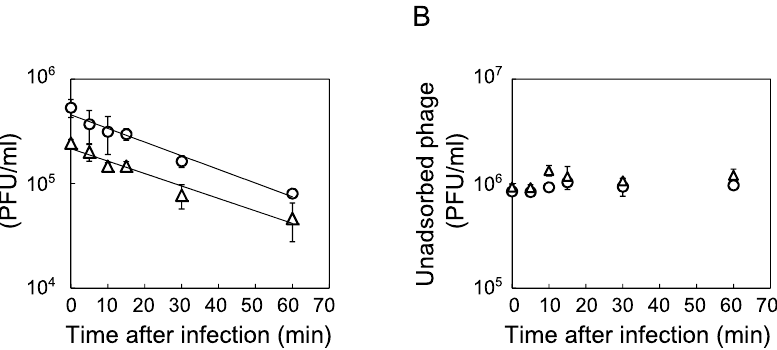
Figure 4. Time course of changes in density of free phage, infected E.coli , and total E.coli . The time course of changes in free phage density (PFU/ml) ( e ), infected cell density (PFU/ml) ( # ) and total cell density (CFU/ml) ( D ) for (A) Anc(C) infected with Anc(P), (B) M54(C) infected with Anc(P), (C) M54(C) infected with M54(P), (D) M163(C) infected with Anc(P), (E) M163(C) infected with M54(P), (F) M163(C) infected with M163(P), and (G) M163(C) infected with S94_3(P). Experiments were performed in duplicate. The rates of infected cell fitting straight lines to semi-logarithmic plots of infected cell density for (A) to (G) were 2.62 h 2 1 (r 2 =0.98), 1.21 h 2 1 (r 2 =0.89), 1.26 h 2 1 (r 2 =0.98), 2.40 h 2 1 (r 2 =0.98), 2.80 h 2 1 (r 2 =0.92), 2.72 h 2 1 (r 2 =0.99), and 2.13 h 2 1 (r 2 =0.91), respectively. The amplification rates of free phage fitting straight lines to semi-logarithmic plots of free phage density for (A) to (G) were 2.43 h 2 1 (r 2 =0.97), 0.11 h 2 1 (r 2 =0.43), 0.31 h 2 1 (r 2 =0.93), 0.25 h 2 1 (r 2 =0.79), 0.24 h 2 1 (r 2 =0.89), 1.38 h 2 1 (r 2 =0.93), and 0.27 h 2 1 (r 2 =0.74), respectively.